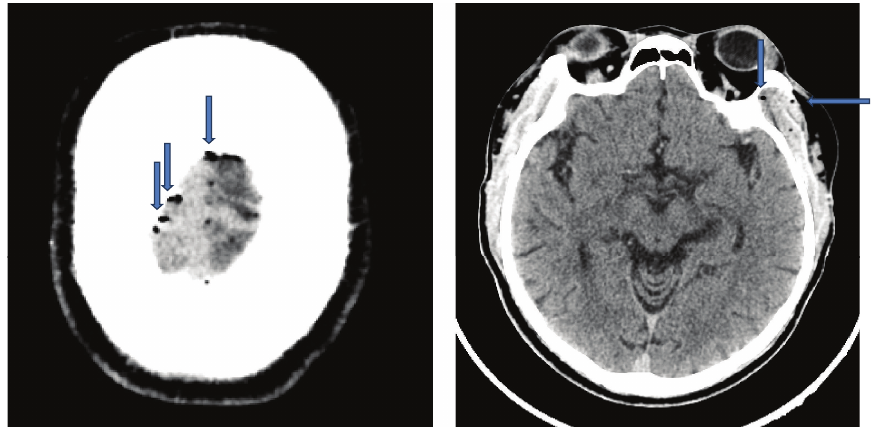
Figure 1: Case 1 CT scan of head: axial cuts showing foci of gas in cerebral vein and left temporal muscle (blue arrows).